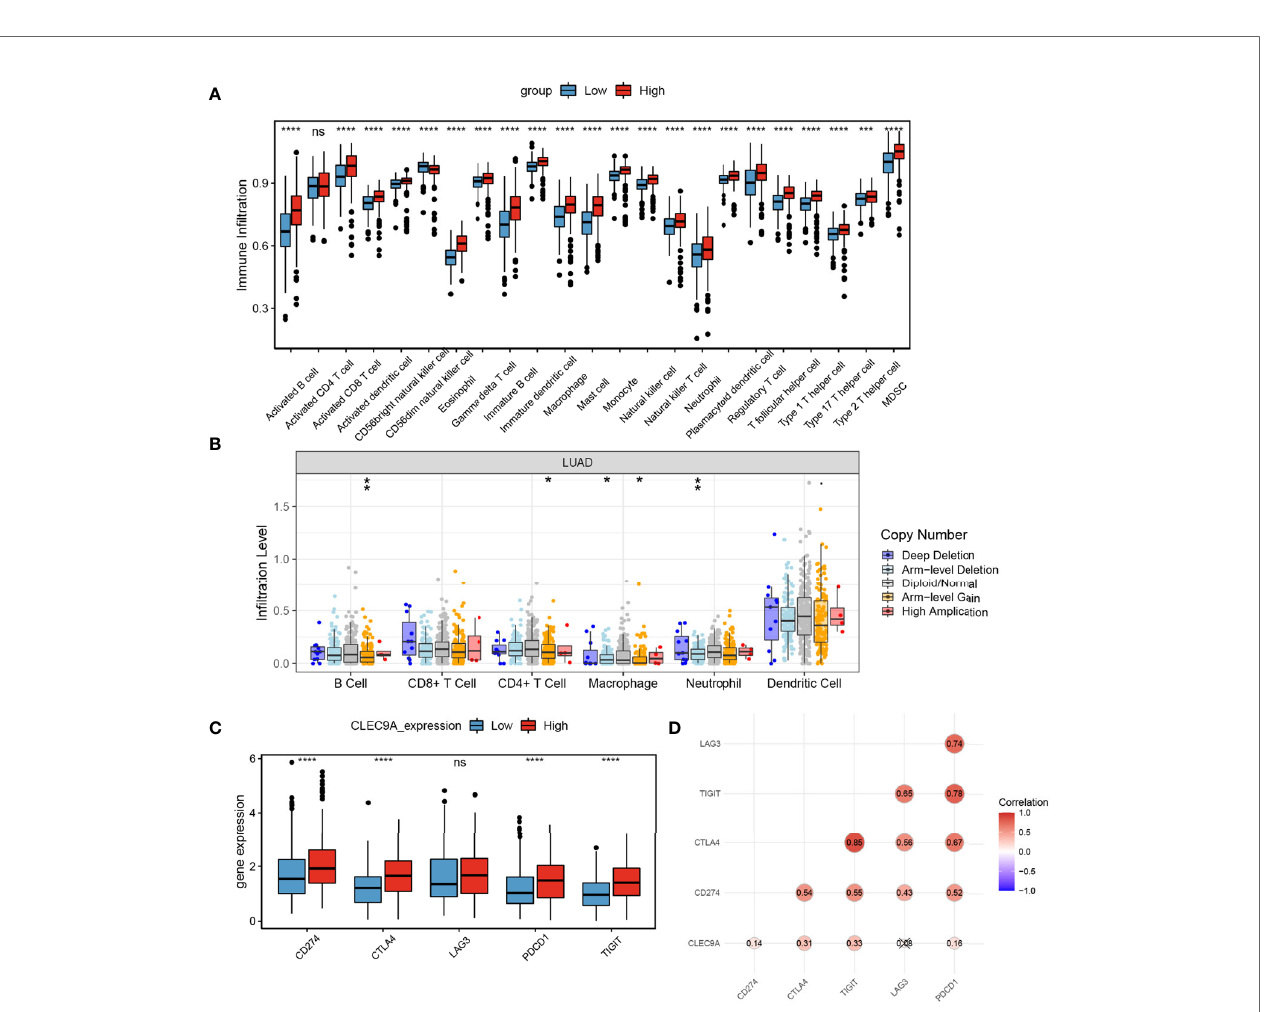
FIGURE 7 | The effects of CLEC9A expression on immune cell in fi ltration. (A) Comparison of immune cell in fi ltration among high and low CLEC9A expression groups using ssGSEA analysis. (B) Effect of the genetic alterations of CLEC9A expression on immune cell in fi ltration. (C) Expression of immune checkpoints between low CLEC9A expression groups. (D) The relationship between immune checkpoints and CLEC9A expression. ns, not signi fi cant. * p < 0.05, ** p < 0.01, *** p < 0.001, **** p <